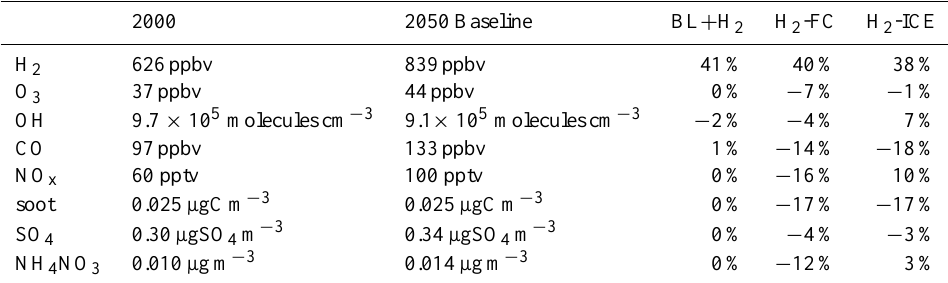
Table 1. Tropospheric mean mixing ratios or concentrations for the 2000 atmosphere, the 2050 A1FI baseline scenario and percent changes for the baseline + H 2 (BL + H 2 ) , hydrogen fuel cell (H 2 -FC), and hydrogen internal combustion engine (H 2 -ICE) scenarios from the 2050 A1FI baseline scenario simulated by the CAM-Chem